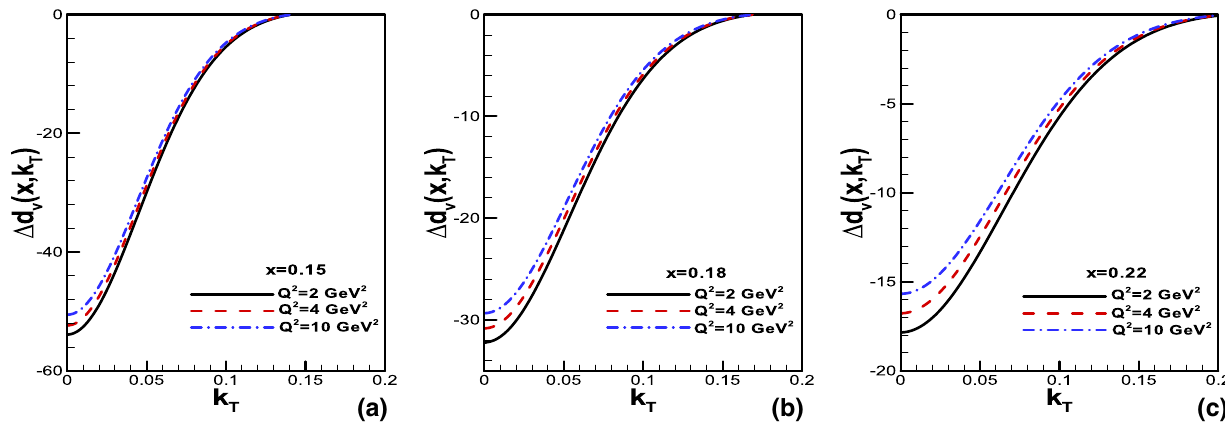
Fig. 15 The k T -distribution of polarized down valence quark at a x = 0 . 15, b x = 0 . 18 and c x = 0 . 22. The TMD polarized valence distributions are plotted at three values of Q 2